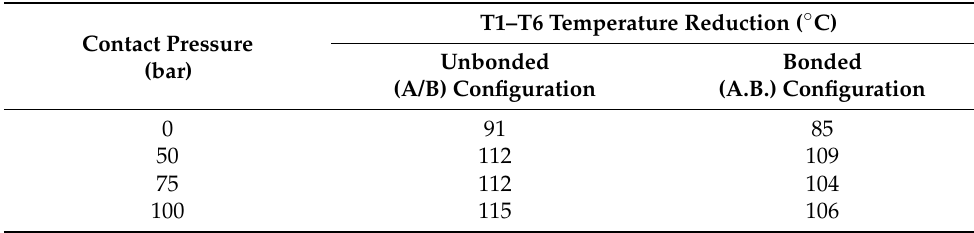
Table 2. Temperature reduction in the unbonded (A/B) and bonded (A.B.) configurations from T1 to T6.